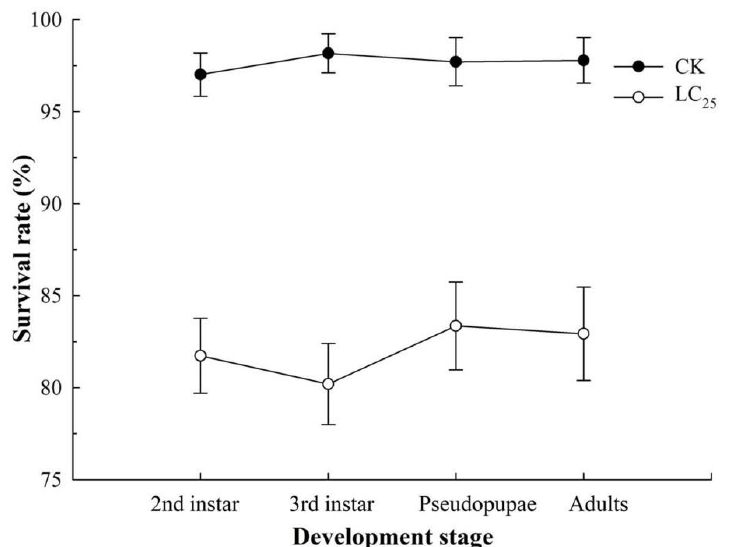
Figure 2. Survival rates of the F 1 generations of B. tabaci in CK and LC 25 treatment groups. Values are presented as means ± SE.